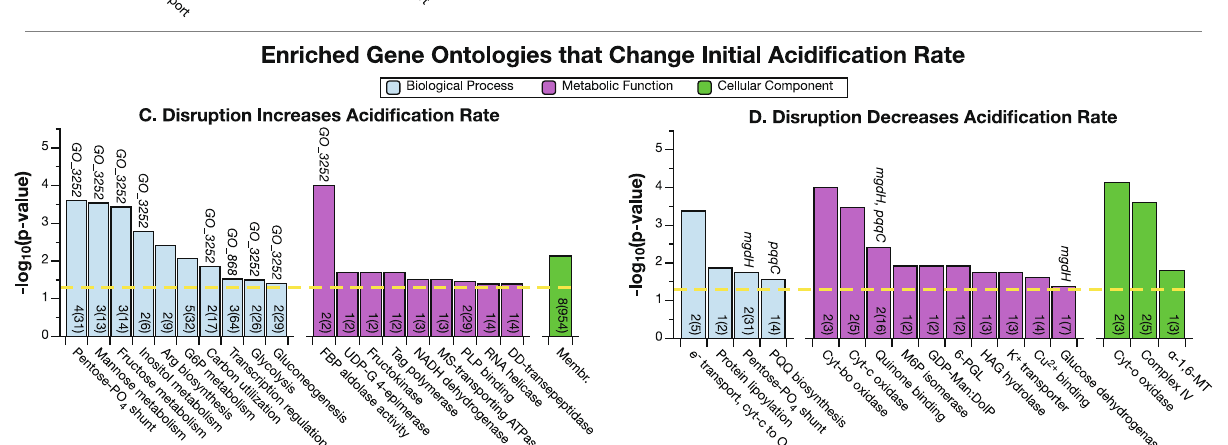
Fig. 3 Genes involved in phosphate signaling, carbohydrate metabolism and PQQ synthesis were signi fi cantly overrepresented in the signi fi cant hits from high-throughput screens of acidi fi cation by G. oxydans . A one-sided Fisher ’ s Exact Test was used to test for gene ontology enrichment ( p <0.05, yellow dashed line). Numbers at the base of bars are how many genes from the signi fi cant hits are from that gene ontology (GO), out of the total in the genome (in parentheses). Genes selected for further analysis of endpoint pH and bioleaching (Fig. 4) that contribute to an enriched GO are listed above the bars. A , B Enriched GO terms among genes that decreased and increased the end point pH. C , D Enriched GO terms among genes that increased and decreased the initial acidi fi cation rate. FBP fructose-bisphosphate, GDP-Man:DolP dolichyl-phosphate beta- D -mannosyltransferase, GGT glutathione hydrolase, G6P glucose 6- phosphate, HTA homoserine O-acetyltransferase, DD-transepeptidase D-Ala-D-Ala carboxypeptidase, HAG hydroxyacylglutathione, Membr membrane, Moco Mo-molybdopterin cofactor, MS monosaccharide, MT mannosyltransferase, M6P mannose-6-phosphate, Pi inorgan i c phosphate, PLP pyridoxal phosphate, PQQ pyrroloquinoline quinone, PSK phosphorelay sensor kinase, Q queuosine, RNase H DNA – RNA hybrid ribonuclease, SAM S-adenosyl- L -methionine, TPP thiamine pyrophosphate, TOP1 topoisomerase type 1, HK histidine kinase, UDP-G uracil-diphosphate glucose, 6-PGL 6-phosphogluconolactonase.